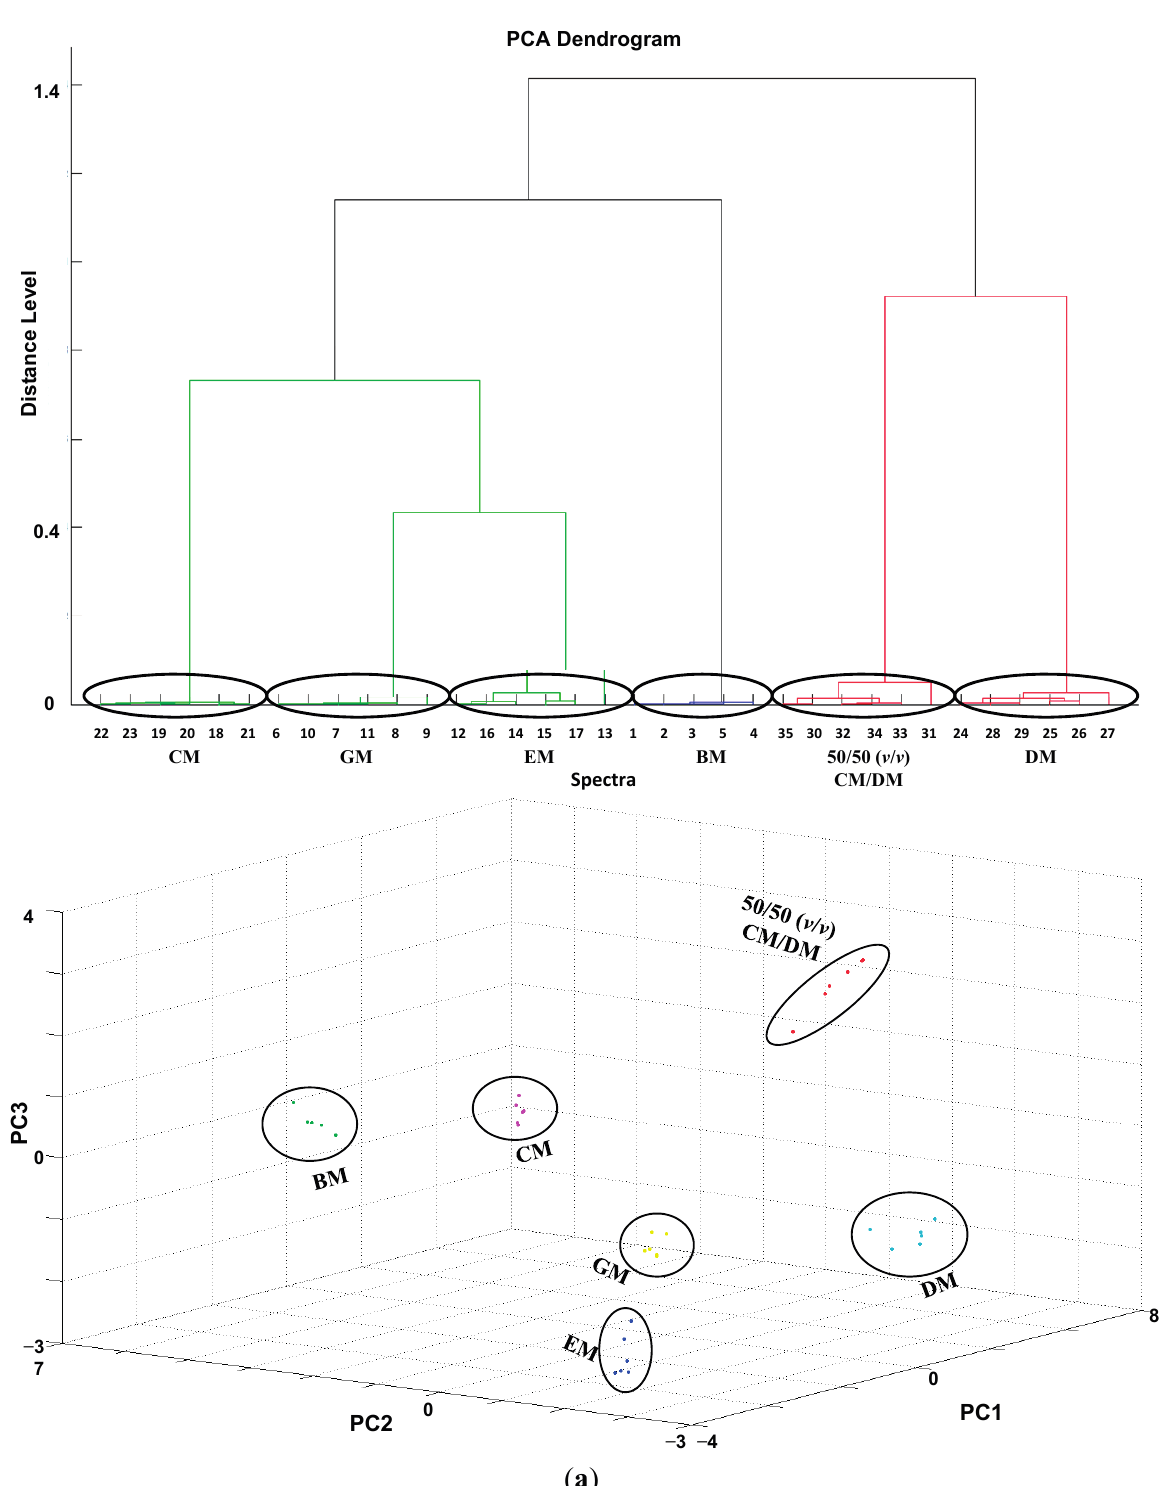
Figure 6. Hierarchical clustering dendrograms and principal component (PCA) 3D scatter plots of the first three principle components for the four mixtures (50%, 10%, 2%, and 0.2%) of the simulated adulteration of DM by CM ( Panels a – d ). All milk adulteration grouped inside the correct clade and